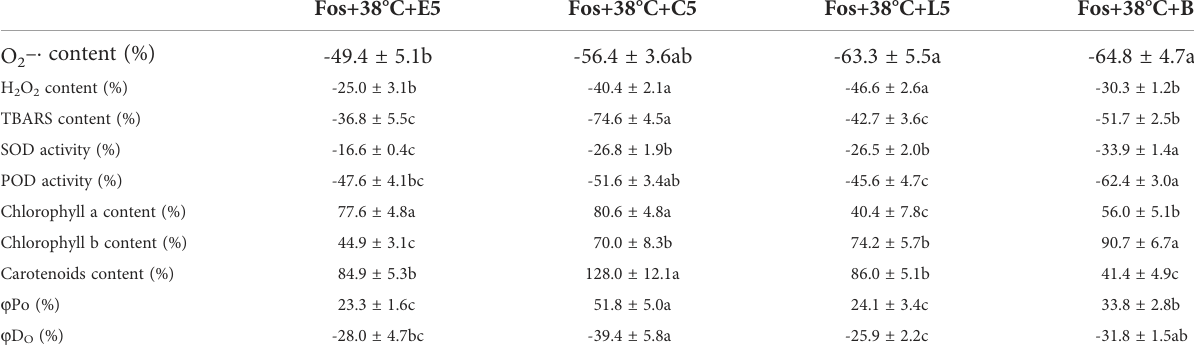
TABLE 3 Variation ratio of the physiological indexes in the uppermost monoterpene fumigation (Fos+38°C+monoterpene) compared with non- fumigation